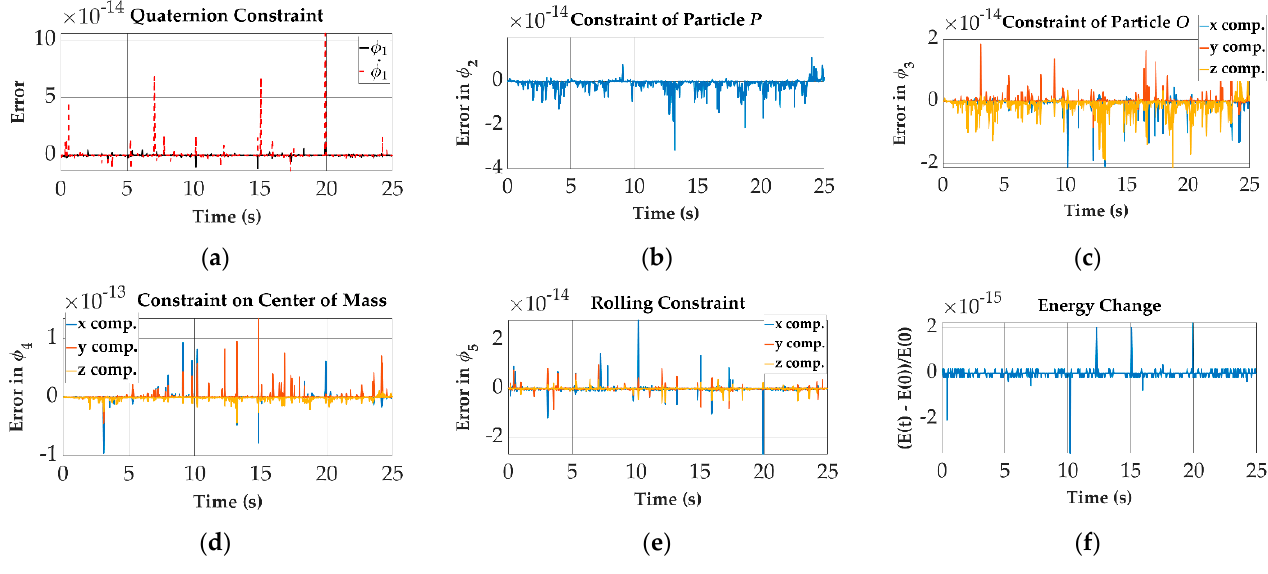
Figure 10. Example 2. Case B. Time history of the numerical errors in the satisfaction of the constraints ( a ) ϕ 1 , ( b ) ϕ 2 , ( c ) ϕ 3 , ( d ) ϕ 4 , ( e ) ϕ 5 , ( f ) normalized ϕ E 1